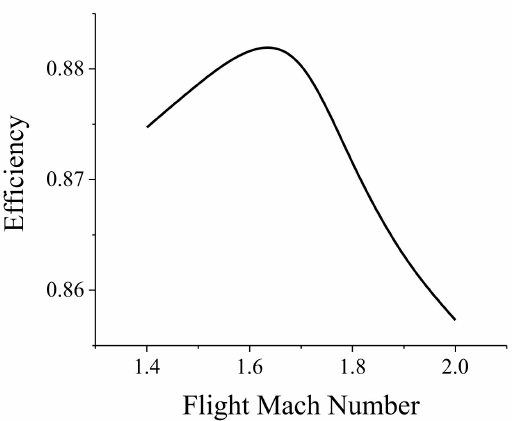
Figure 8. Front Fan Efficiency vs. Flight Mach Number.